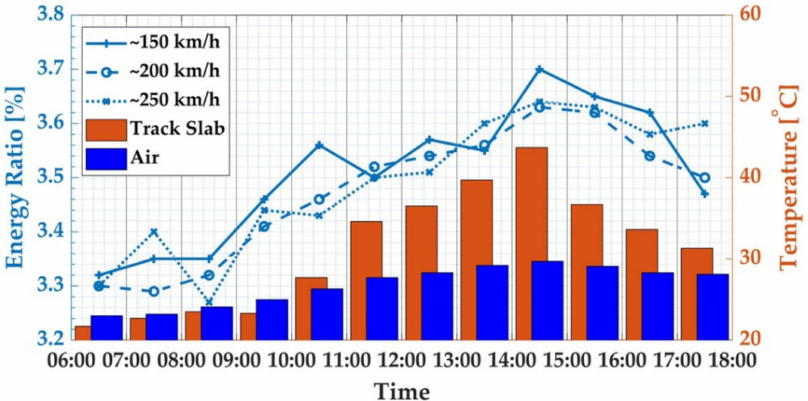
Figure 7. WPT of characteristic frequency band for 30 July 2020, summer.